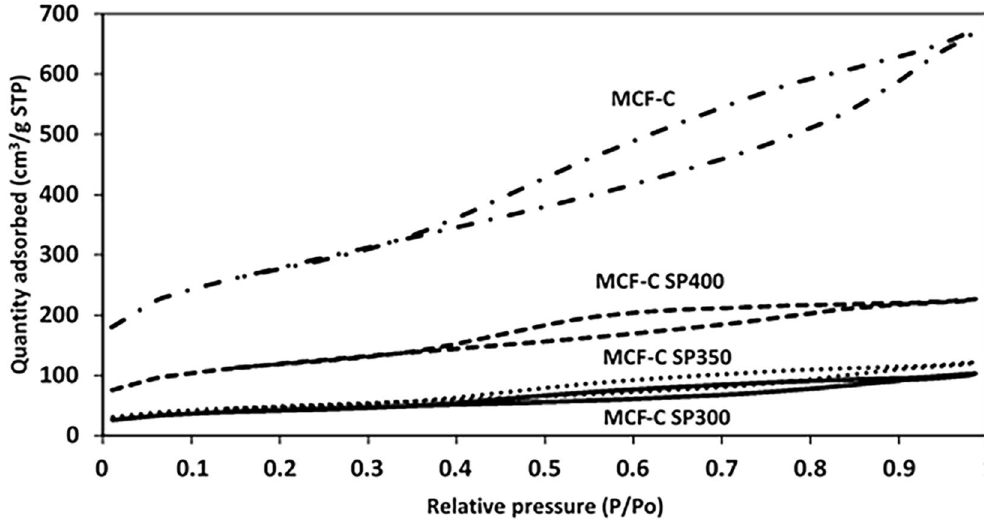
Figure 2. Nitrogen adsorption/desorption isotherms of all stability testing conditions (MCF-C, MCF-C SP300, MCF-C SP350, and MCF-C SP400).